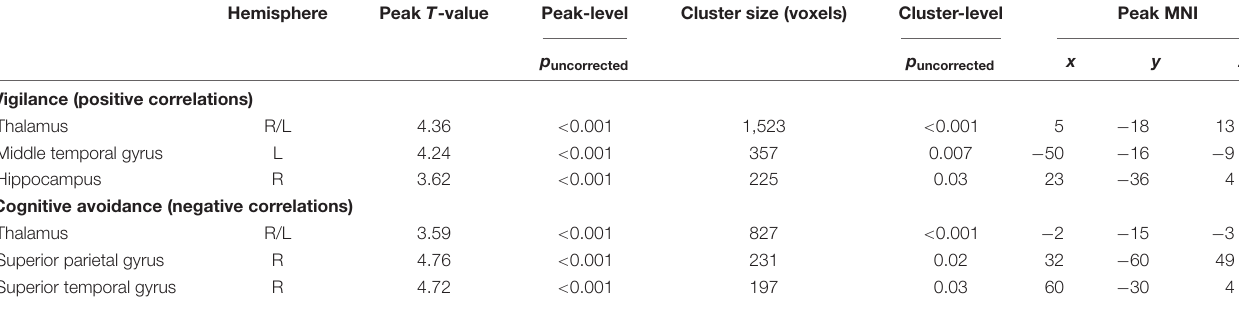
TABLE 2 | Brain regions showing alterations in GM volume as a function of coping styles at a cluster-level threshold of p uncorrected < 0.05.